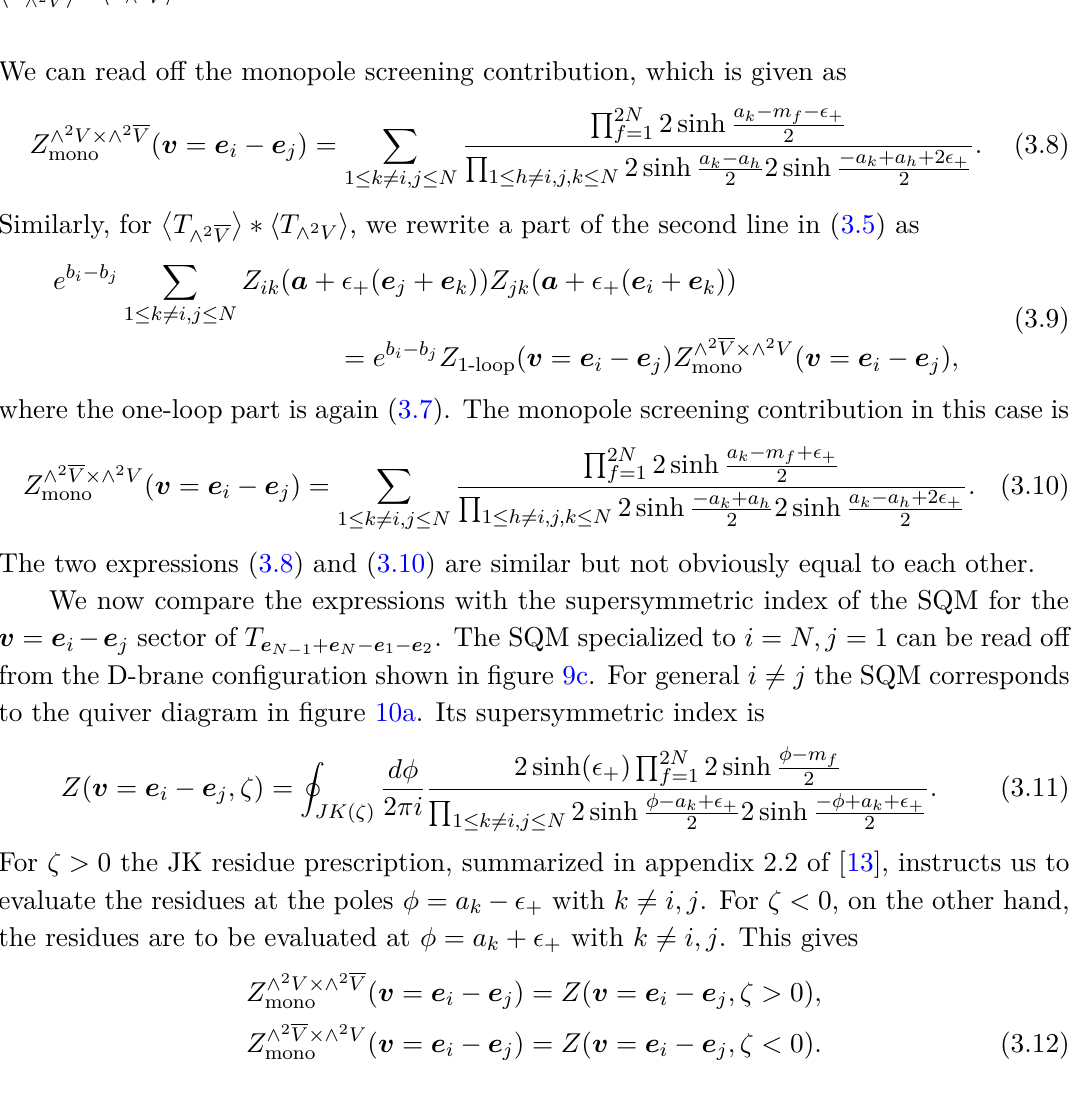
Figure 10. (a) The N = (0 , 4) quiver diagram describing the monopole screetning contribution to the v = e i − e j sector in h T diagram describing the monopole screetning contribution to the v = 0 sector in h T (cid:10) (cid:11) T ∗ h T i ∧ 2 V ∧ 2 V